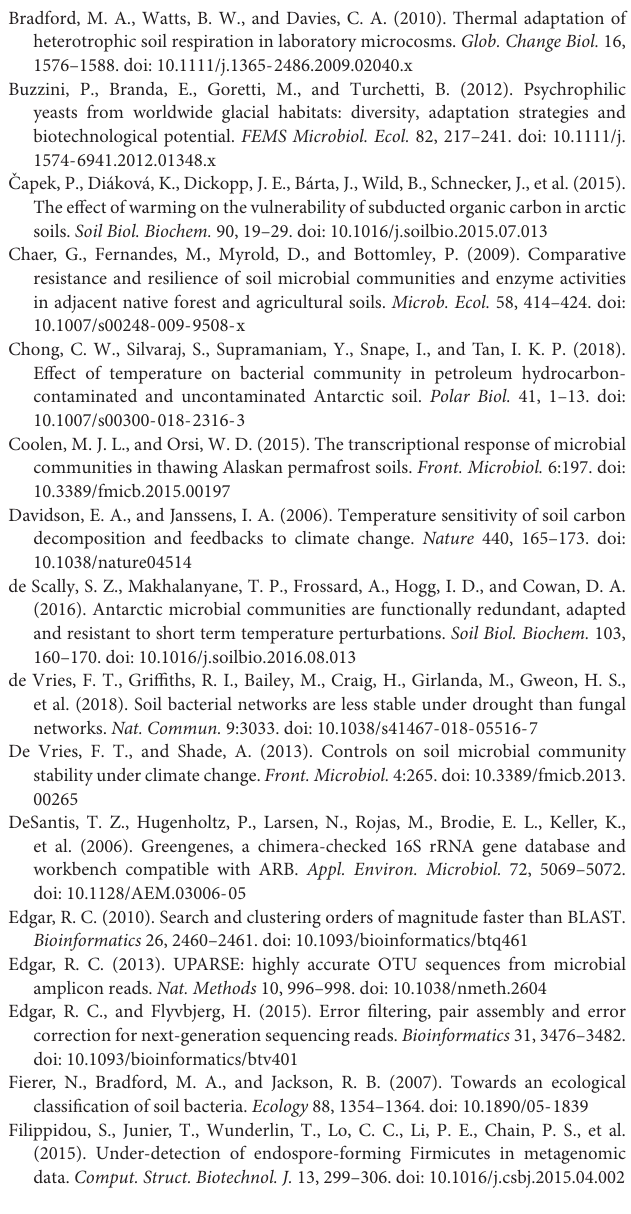
TABLE S2 | Effects of soil origin, temperature, and their interactions on bacterial and fungal alpha-diversity. TABLE S3 | Effects of soil origin, temperature, and their interactions on the most abundant bacterial taxa (phyla or class). TABLE S4 | Effects of soil origin, temperature, and their interactions on the most abundant fungal